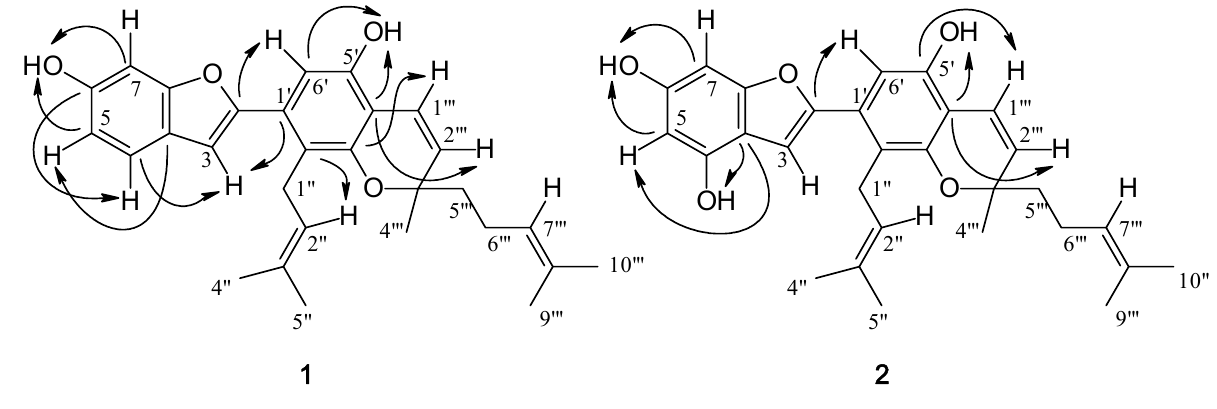
Figure 3. Important HMBC (C → H) correlations of 1 and 2